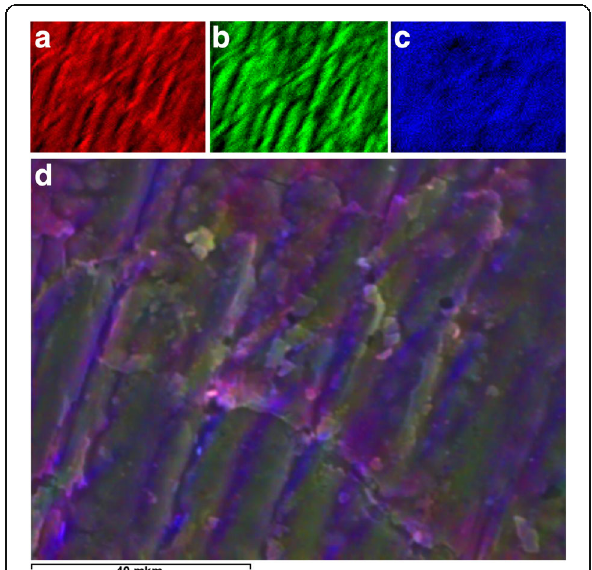
Fig. 9 The elemental analysis results. The elemental map of the surface of the composite with 20 phr LiClO 4 : a C, b O, c Cl, and the d combined